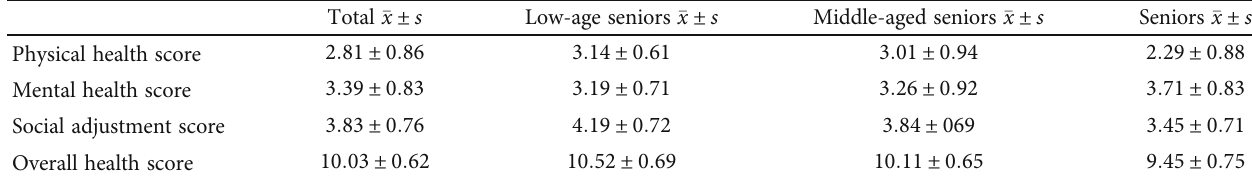
Table 2: Health scores of older adults in di ff erent age groups in Nanjing.